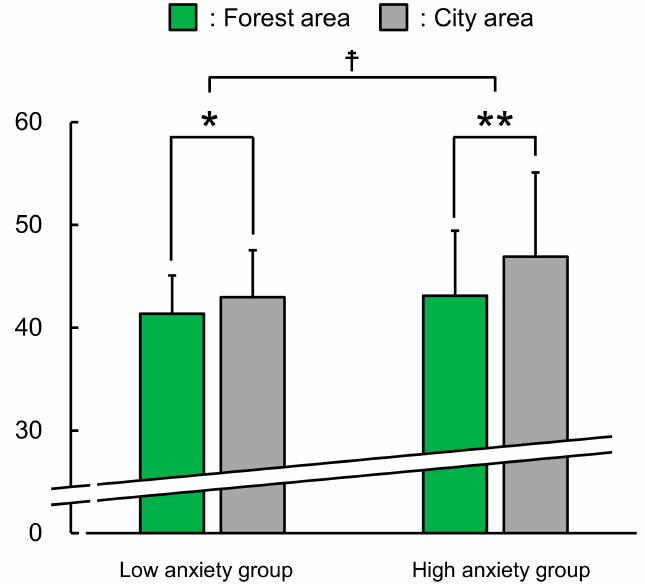
Figure 6. Comparison between groups with high and low anxiety levels with regard to experiencing confusion after viewing forest and city areas. Participants with low anxiety levels: n = 52; participants with high anxiety levels: n = 350. Mean ± standard deviation. } p < 0.05 (comparing groups) decided by Mann–WhitneyUtest, ** p < 0.01, * p <